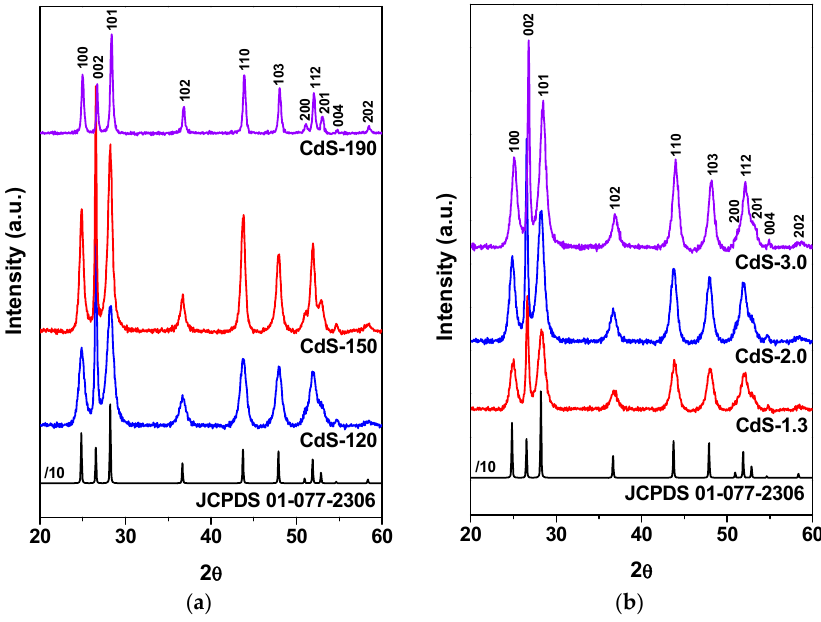
Figure 2. Powder XRD patterns of CdS samples: ( a ) influence of solvothermal temperature (CdS-120, 150 and 190); ( b ) influence of H 2 O/thiourea ratio (CdS-1.3, 2.0 and 3.0). Table 2. Structural properties of CdS samples determined from XRD data.